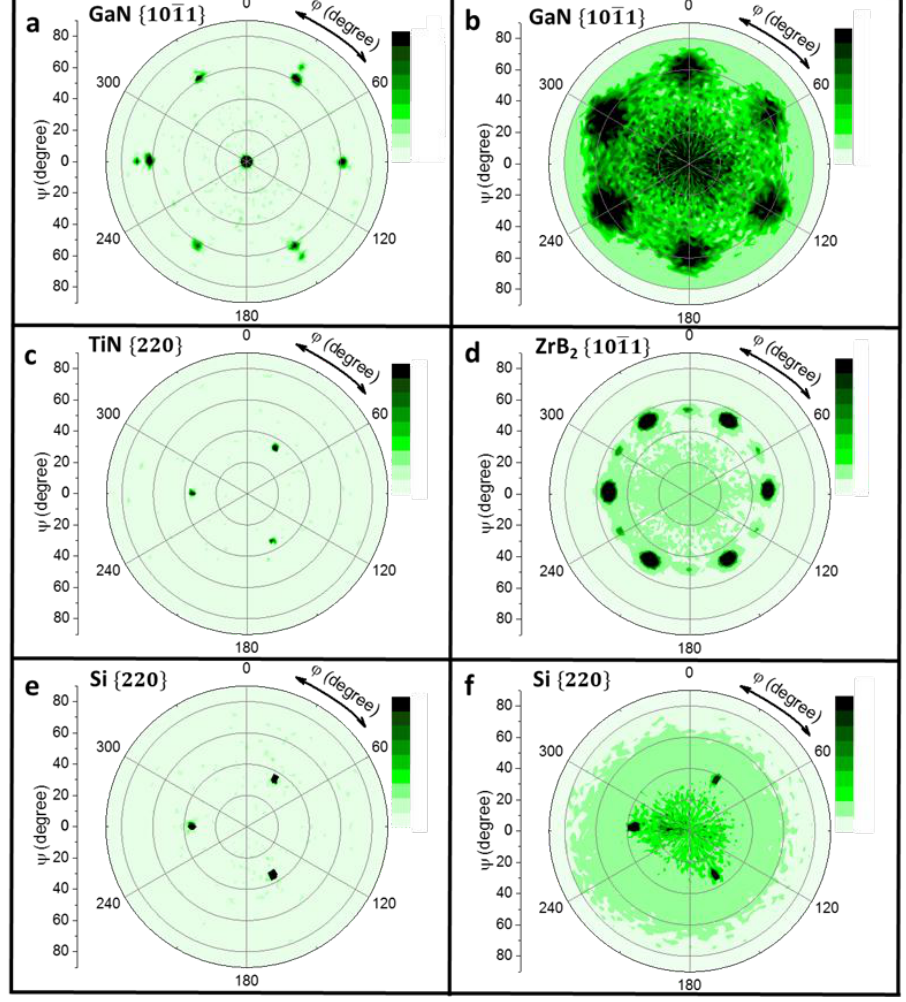
Figure 7. Pole-figure XRD measurements of GaN NRs grown on TiN/Si and ZrB 2 /Si templates shown in (a, c, e) and (b, d, e), respectively. The corresponding pole figures in these two samples are ( a ) 10 1̅ 1 GaN, ( c ) 220 TiN, and ( e ) 220 Si, as well as ( b ) 10 1̅ 1 GaN, ( d ) 10 1̅ 1 ZrB 2 , and ( f ) 220 Si, respectively.